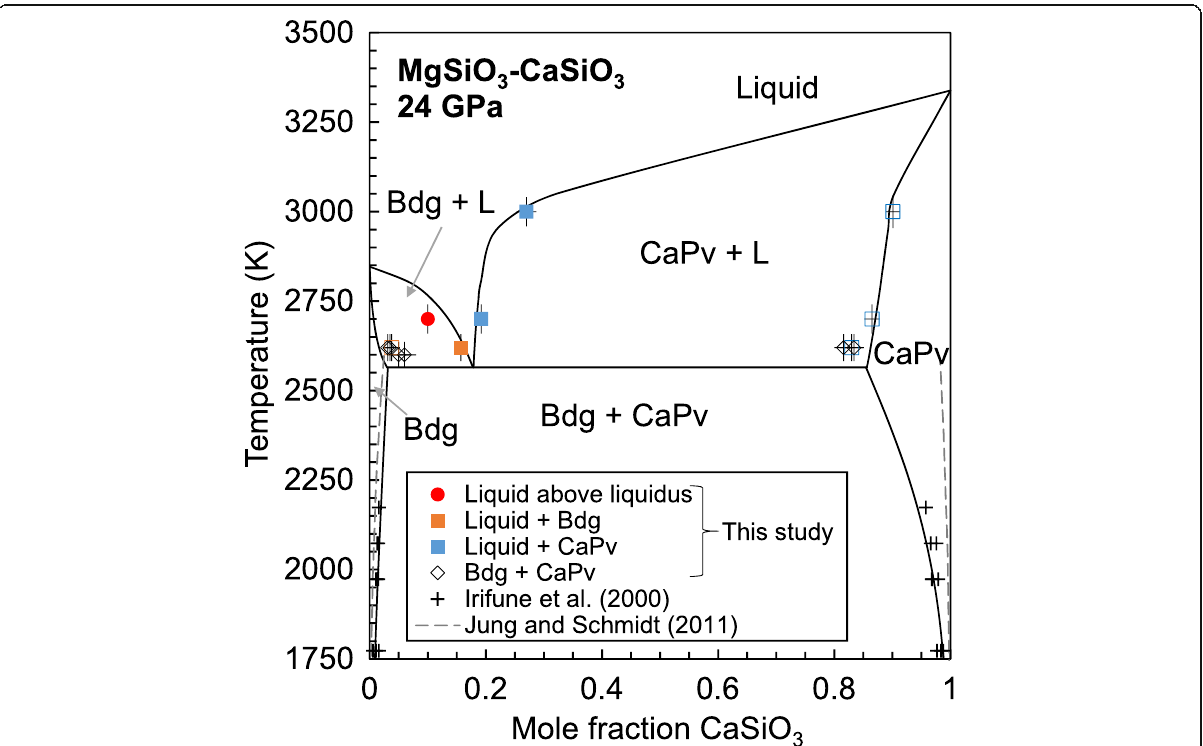
Fig. 7 Melting phase diagram in the MgSiO 3 – CaSiO 3 system at 24 GPa. The filled red circle represents the composition of liquid above liquidus, the filled and open orange squares represent the liquid and coexisting bridgmanite (Bdg), the filled and open blue squares represent the liquid and coexisting CaSiO 3 -rich perovskite (CaPv), the open diamonds represent the subsolidus phases, the cross symbols represent the subsolidus phases at 25 and 27 GPa reported in Irifune et al. (2000), and the dashed gray line represents the subsolidus phases at 25 GPa reported in Jung and Schmidt